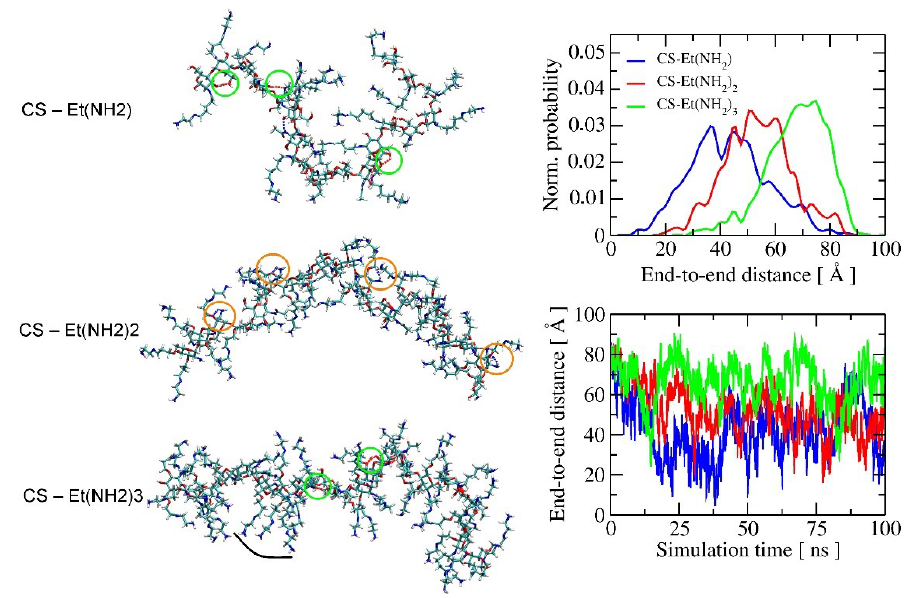
Figure 7. Structuring of modified chitosan polymers with molecular dynamics simulations using the extended CHARMM36 force field for carbohydrates. The selected snapshots of CS-Et(NH 2 ) 1–3 conformations are shown in the panel on the left, while the flexibility/stiffness of the polymer chains as a function of the end-to-end distance is shown in the panel on the right. A description of the computational setup is provided in the Section 3.2.5.: computational details. Structuring of the CS-Et(NH 2 ) 2 polymer is induced by a different type of H-bonding, i.e., N- H···O, which is marked in orange circles in Figure 7 for clarity. N-H···O H-bonds, formed near the